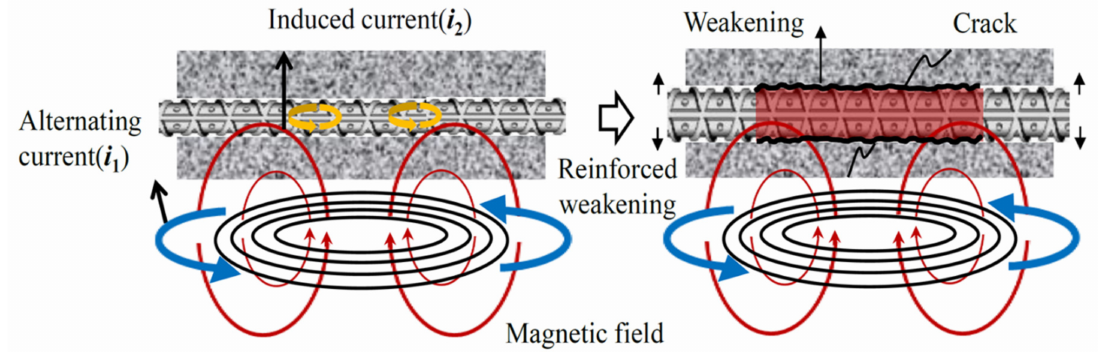
Figure 2. Model of reinforced concrete member vulnerability by induction heating.